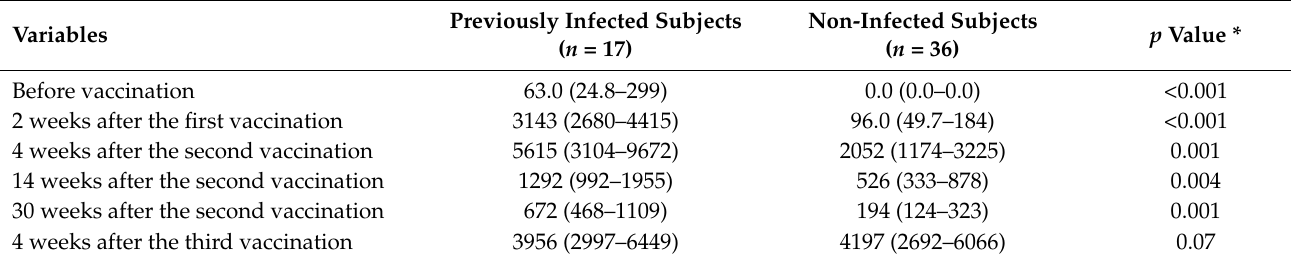
Table 2. Anti-SARS-CoV-2 antibody titers in medical staff.